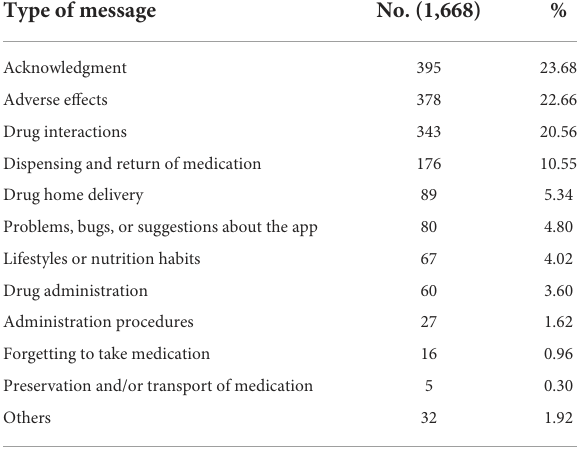
TABLE 4 The most frequent types of messages sent by patients through the